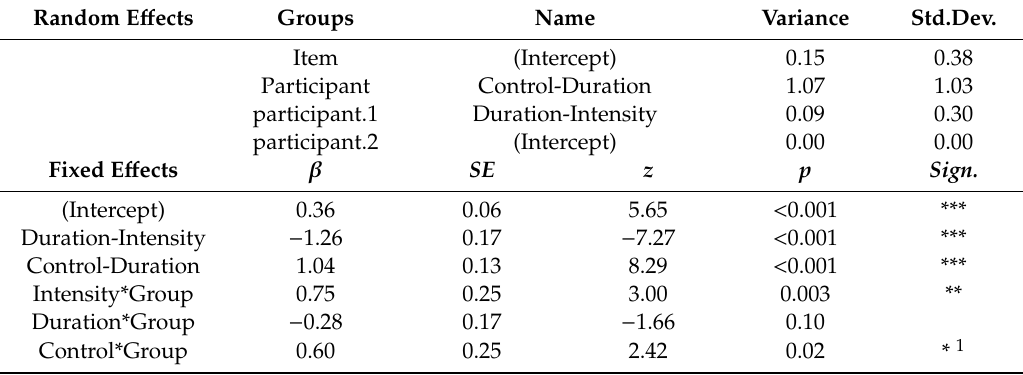
Table A5. Output of the first model exploring the e ff ects of group on the three conditions.